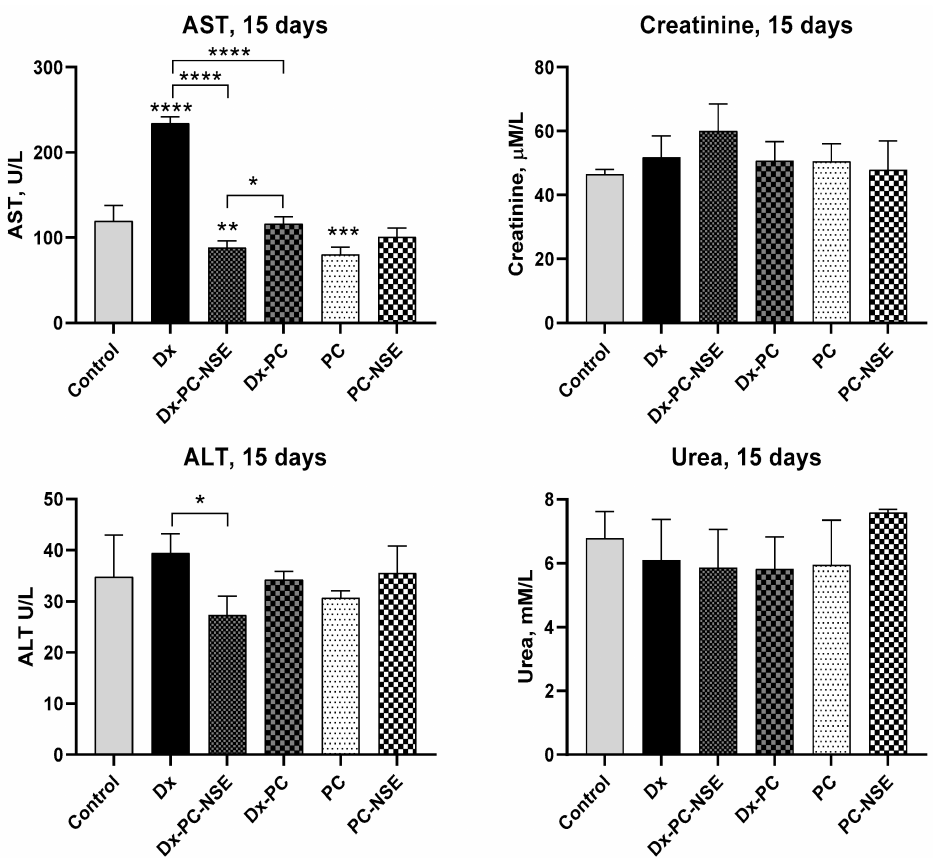
Figure 12. Changes in markers of hepato-and nephrotoxicity in Balb/c mice under treatment with sub-lethal dose of Dx (20 mg/kg), Dx-PC, and Dx-PC-NSE (n = 5). Significance to control and other groups was calculated with one-way ANOVA and Tukey’s multiple comparison test (* p ≤ 0.05, ** p ≤ 0.01, *** p < 0.001, **** p <